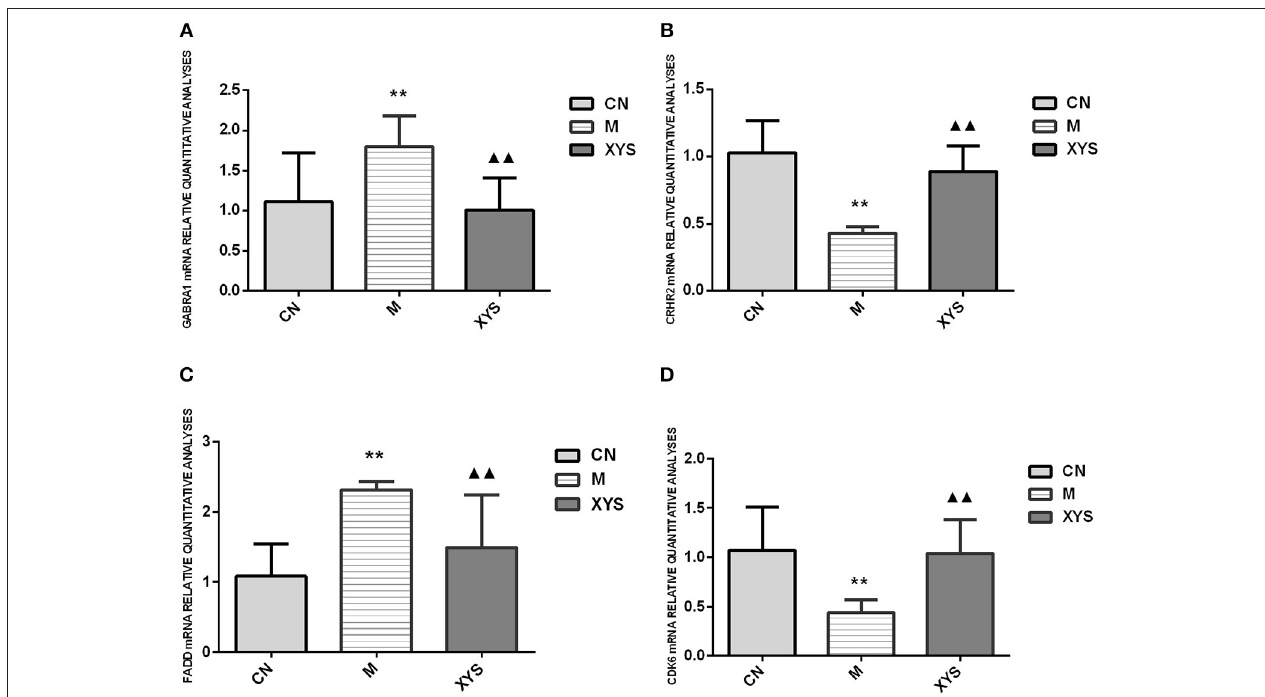
FIGURE 3 | Relative quantitative analyses of the expression of the GABRA1, CRHR2, FADD, and CDK6 mRNAs in the rat hippocampal tissues from each group. (A) Relative quantitative analyses of GABRA1 mRNA expression in each group. (B) Relative quantitative analyses of CRHR2 mRNA expression in each group. (C) Relative quantitative analyses of FADD mRNA expression in each group. (D) Relative quantitative analyses of CDK6 mRNA expression in each group. ** P < 0.01 compared with the control group. NN P < 0.01 compared with the model